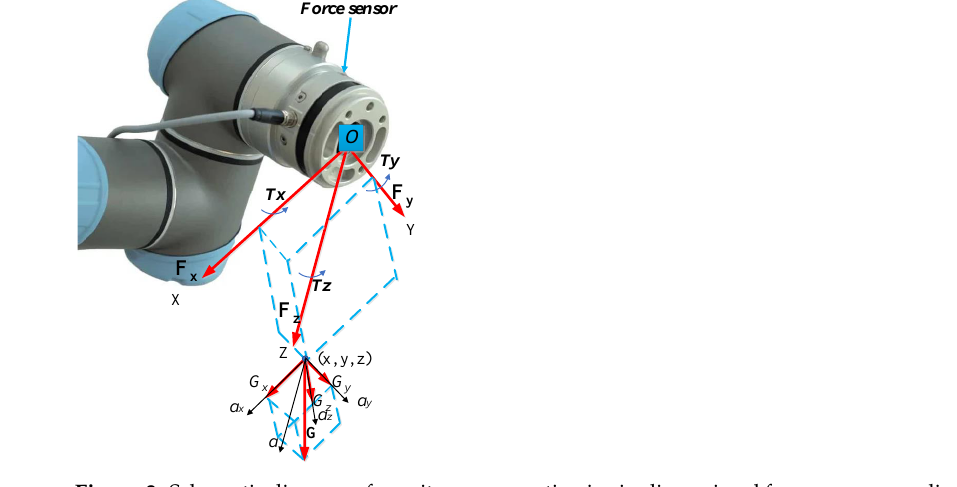
Figure 3. Schematic diagram of gravity compensation in six-dimensional force sensor coordinate system. The variable α represents the angular acceleration of the robot coordinate system, (cid:2) (cid:3) T and a x ,a y ,a z is the acceleration of the end coordinate system itself. 0 0 0